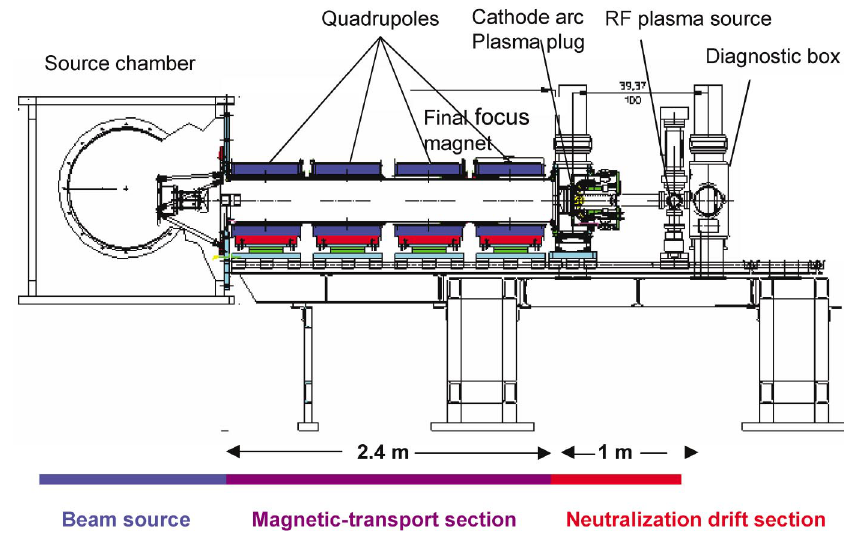
FIG. 3. (Color) Schematic of the NTX beam